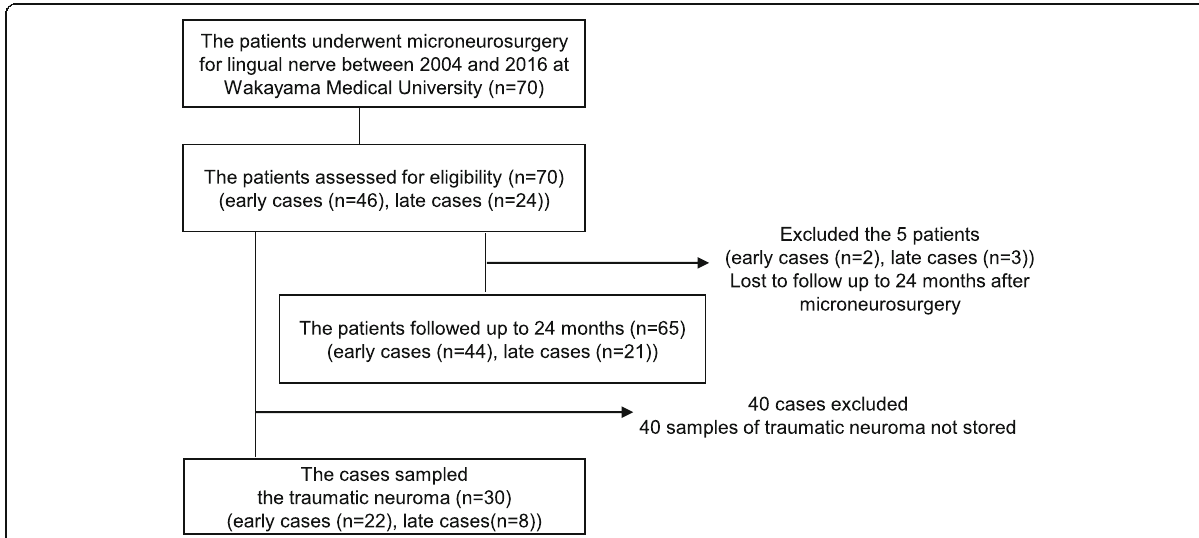
Fig. 1 Trial profile. All patients underwent microneurosurgery for lingual nerve injury caused by third molar extraction at Wakayama Medical University Hospital between 2004 and 2016. Sixty-five out of 70 patients could be followed up to 24 months. Thirty traumatic neuroma samples were analyzed using